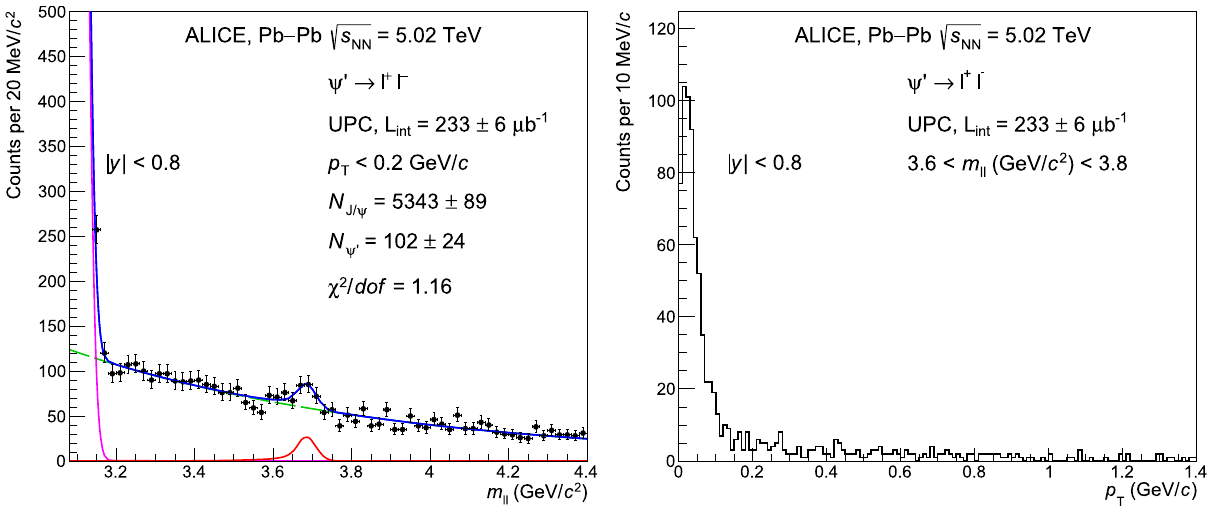
Fig. 3 Left:Invariantmassdistributionof l + l − pairs.Thedashedgreen line corresponds to the background description. The solid magenta and red line correspond to Crystal Ball functions representing the J /ψ and ψ (cid:2) signals, respectively. The solid blue line corresponds to the sum of